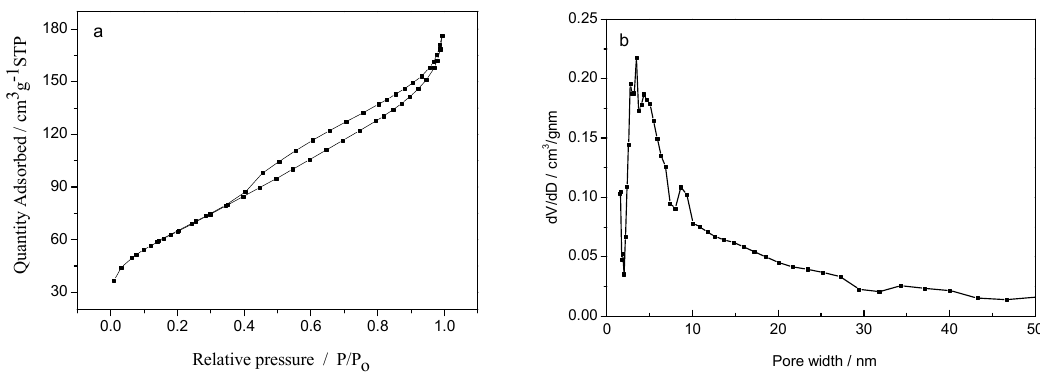
Figure 3. ( a ) Nitrogen adsorption–desorption isotherms and ( b ) Barrett–Joyner–Halenda (BJH) pore size distribution of R-TiO 2 /SiO 2 samples.